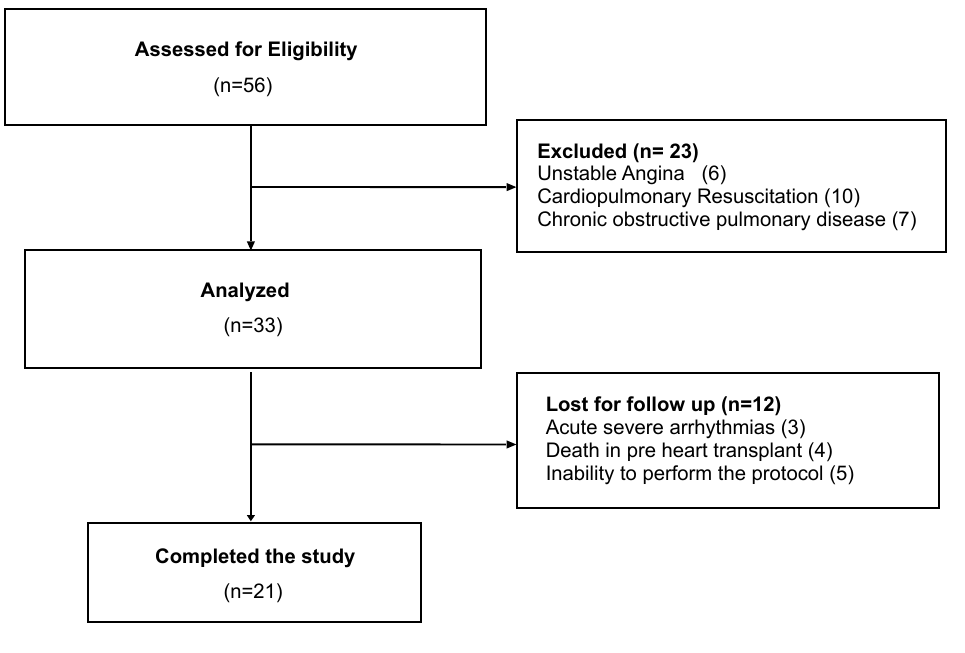
Fig. 1 – Flowchart of the study evaluation